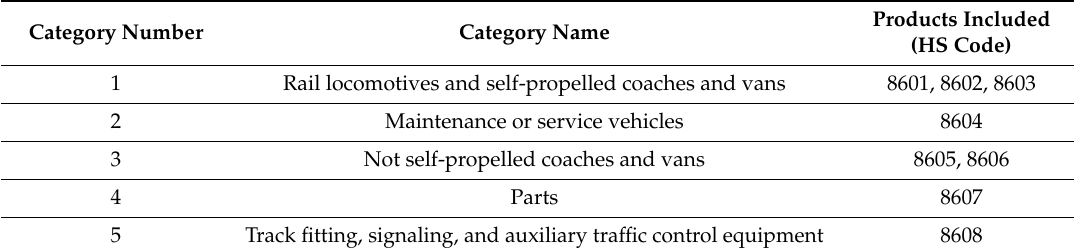
Table 1. Classification of rolling stock